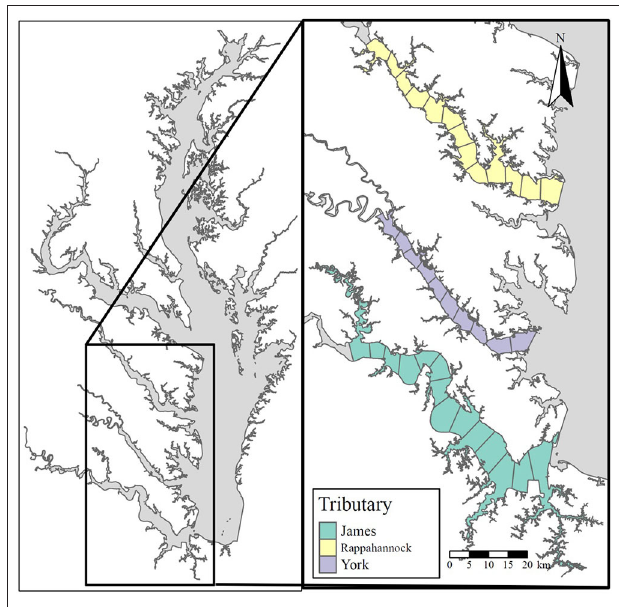
FIGURE 1 | Map of Rappahannock, James, and York rivers with tributary sections (areal units) superimposed. See the Sampling and Data Processing Section for the definition of areal units within tributaries.